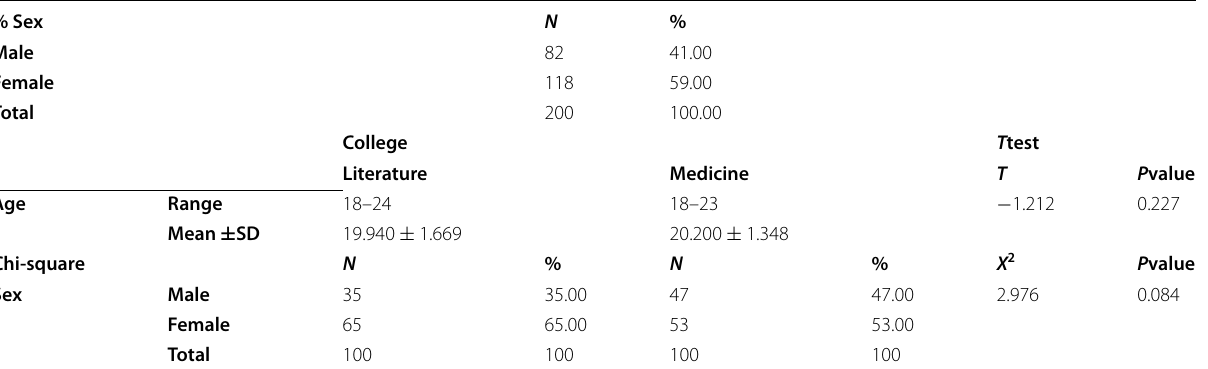
Table 1 Descriptive data of the